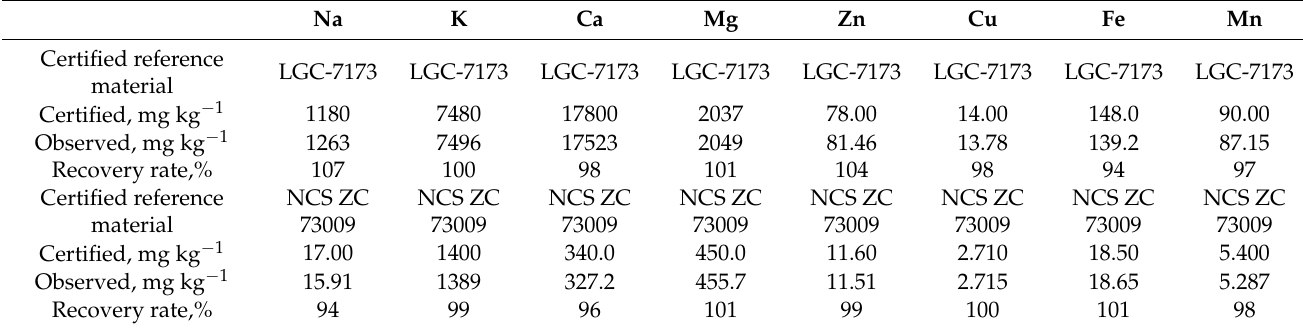
Table 2. Data of triplicate certified reference materials